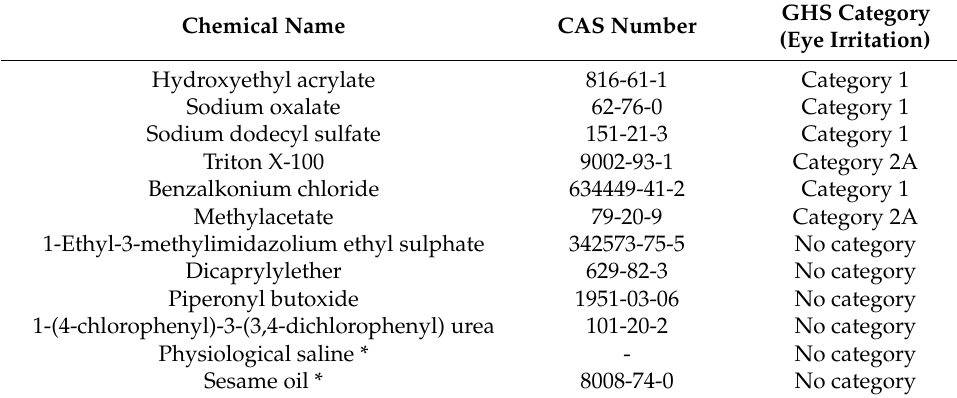
Table 1. Characteristics of eye-irritating and non-eye-irritating chemicals